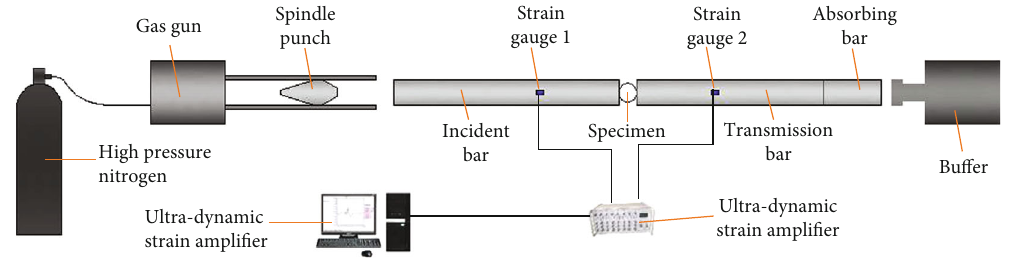
Figure 1: SHPB system